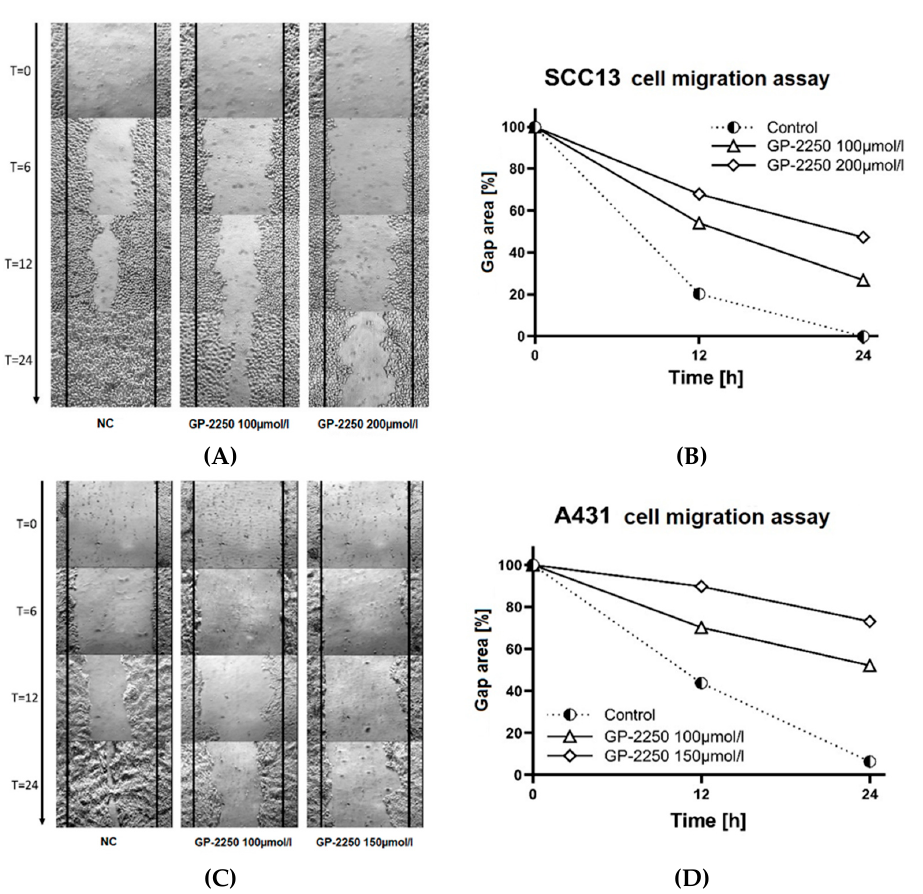
Figure 5. The substance GP-2250 reduces cutaneous squamous carcinoma cell motility in the cell migration assay. Representative images of the SCC13 cells treated with GP-2250 or negative control at 0 h, 6 h, 12 h and 24 h after the scratches were made (×10 magnification) ( A ) and related percentage of total gap closure at 0 h, 12 h and 24 h ( B ) Representative images of the A431 cells transfected with GP-2250 or negative control at 0 h, 6 h, 12 h and 24 h after the scratches were made at the same starting point (×10 magnification) ( C ) and related percentage of total gap closure at 0 h, 12 h and 24 h ( D ).